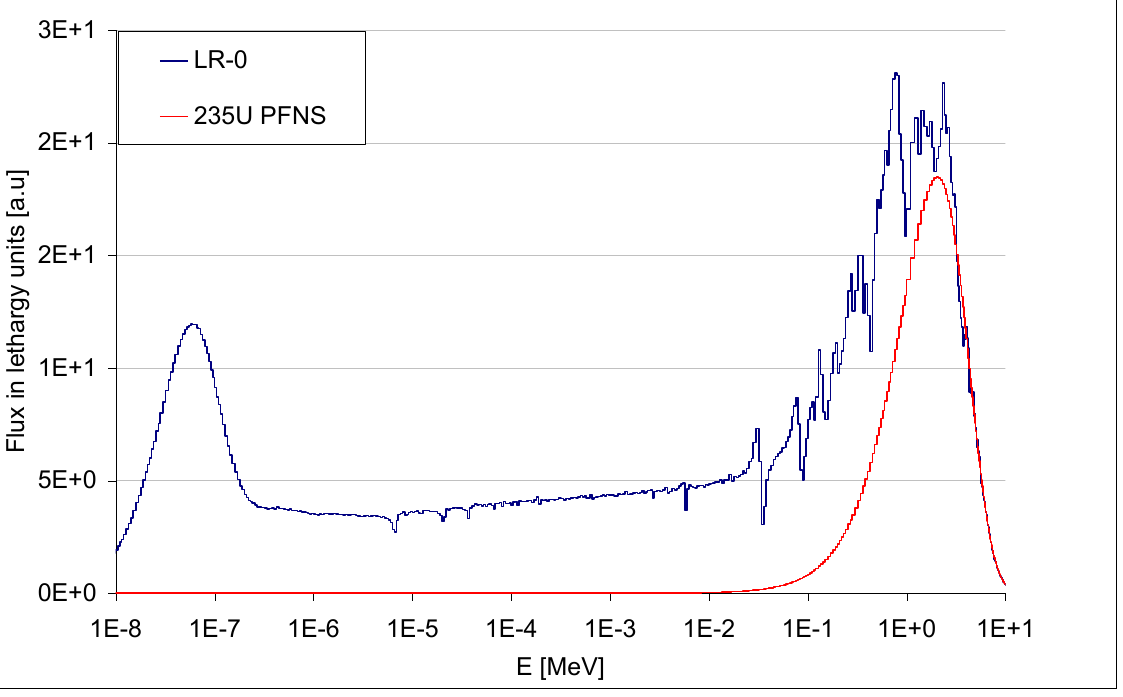
Figure 2. Calculated reactor spectrum and scaled 235 U fission